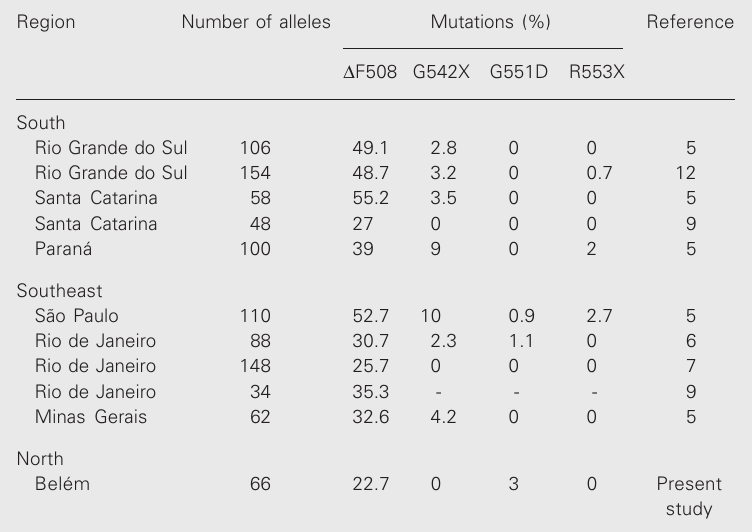
Table 1. The four most prevalent cystic fibrosis mutations in Brazil. Region Number of alleles Mutations (%)